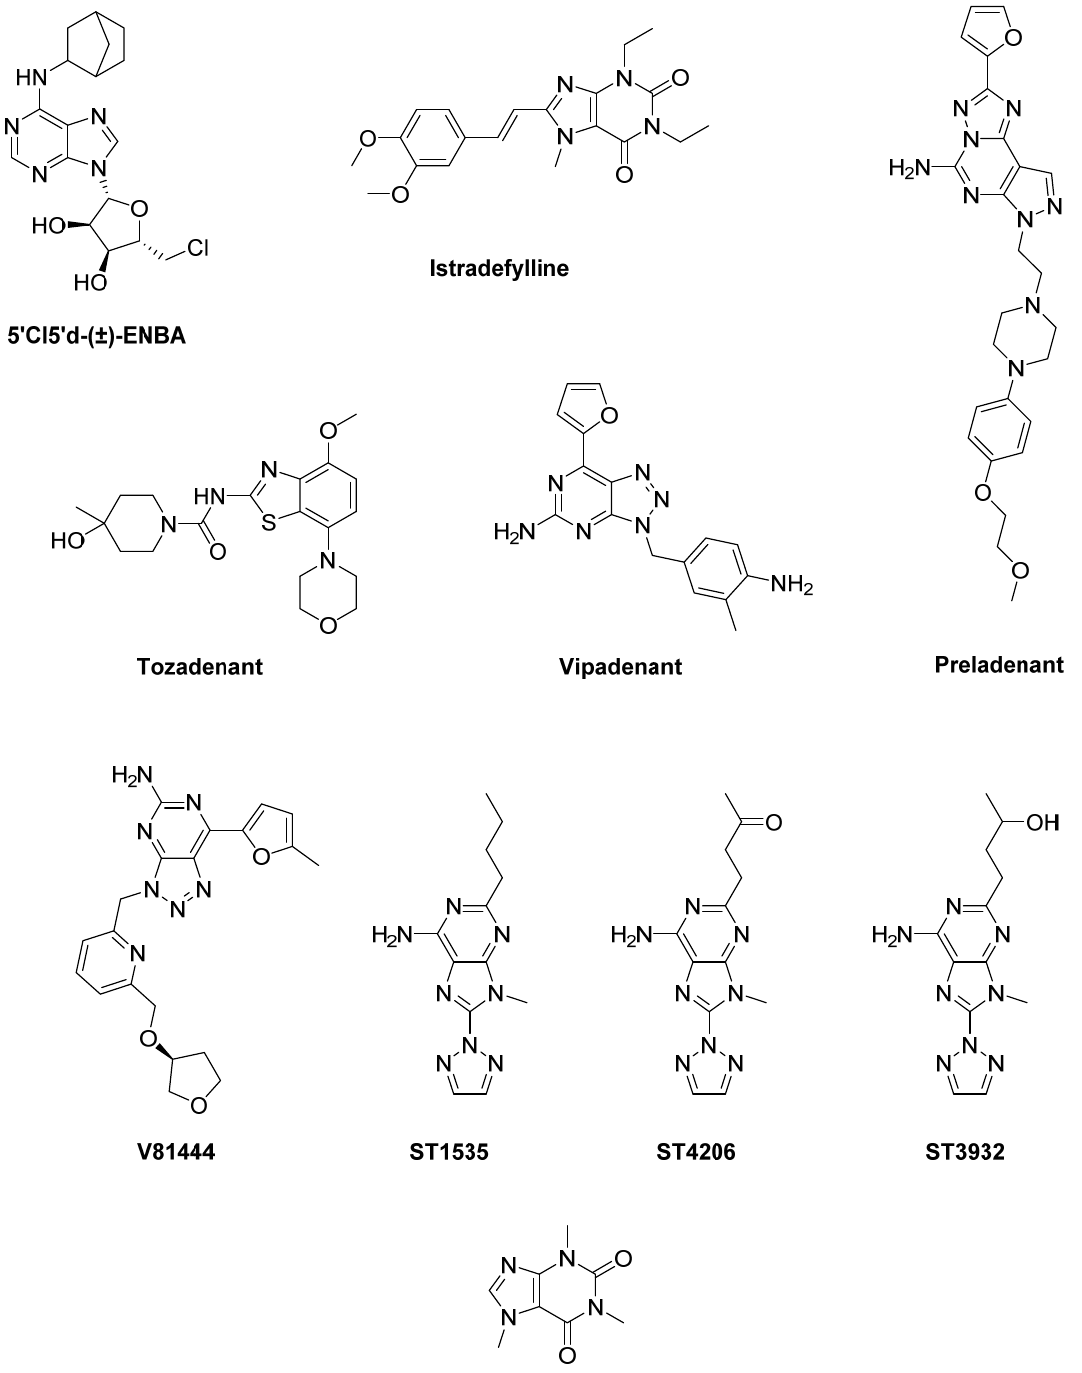
Figure 11. Adenosine receptor ligands.